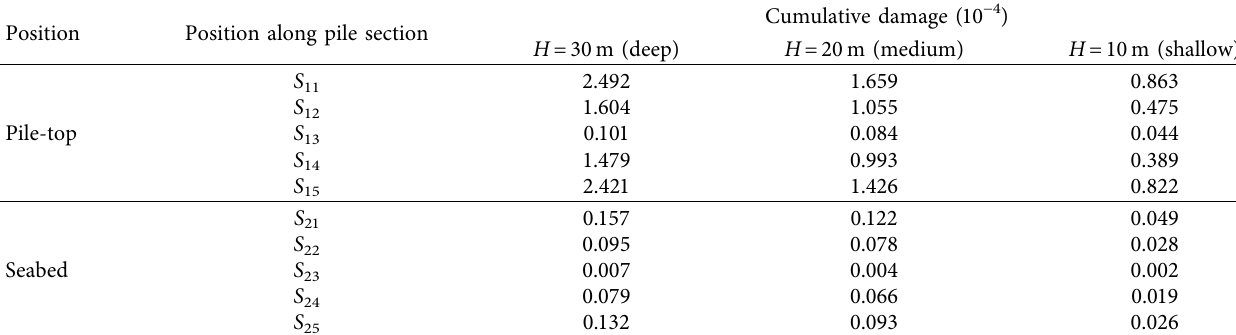
Table 3: 500s cumulative fatigue damage with different water depths (soil strength: 25kPa). Position Position along pile section